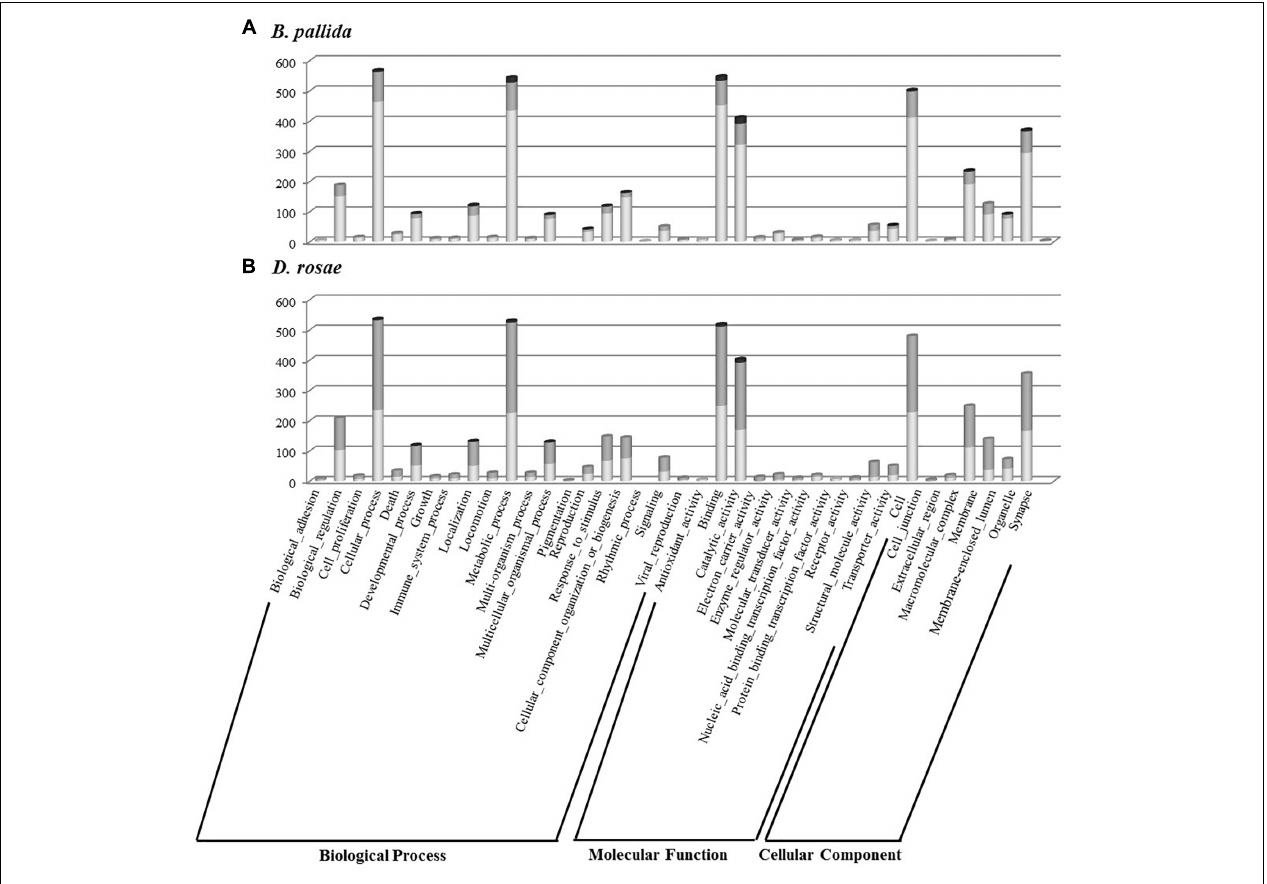
FIGURE 6 | Histogram presentation of Gene Ontology (GO) classification of B. pallida (A) and D. rosae (B) contigs. Results are given in the three GO categories at the level two of GO analysis for contigs highly expressed in venom gland (dark gray), those highly expressed in ovaries (light gray), and those equivalently expressed in the two tissues